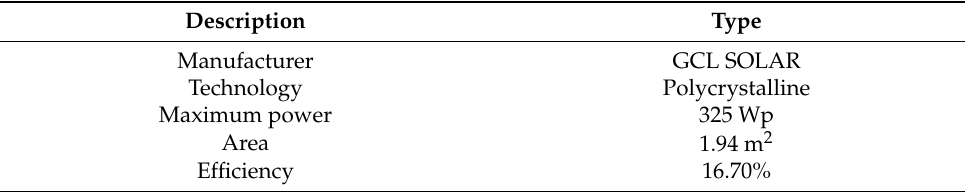
Table 8. PV Module Specifications.